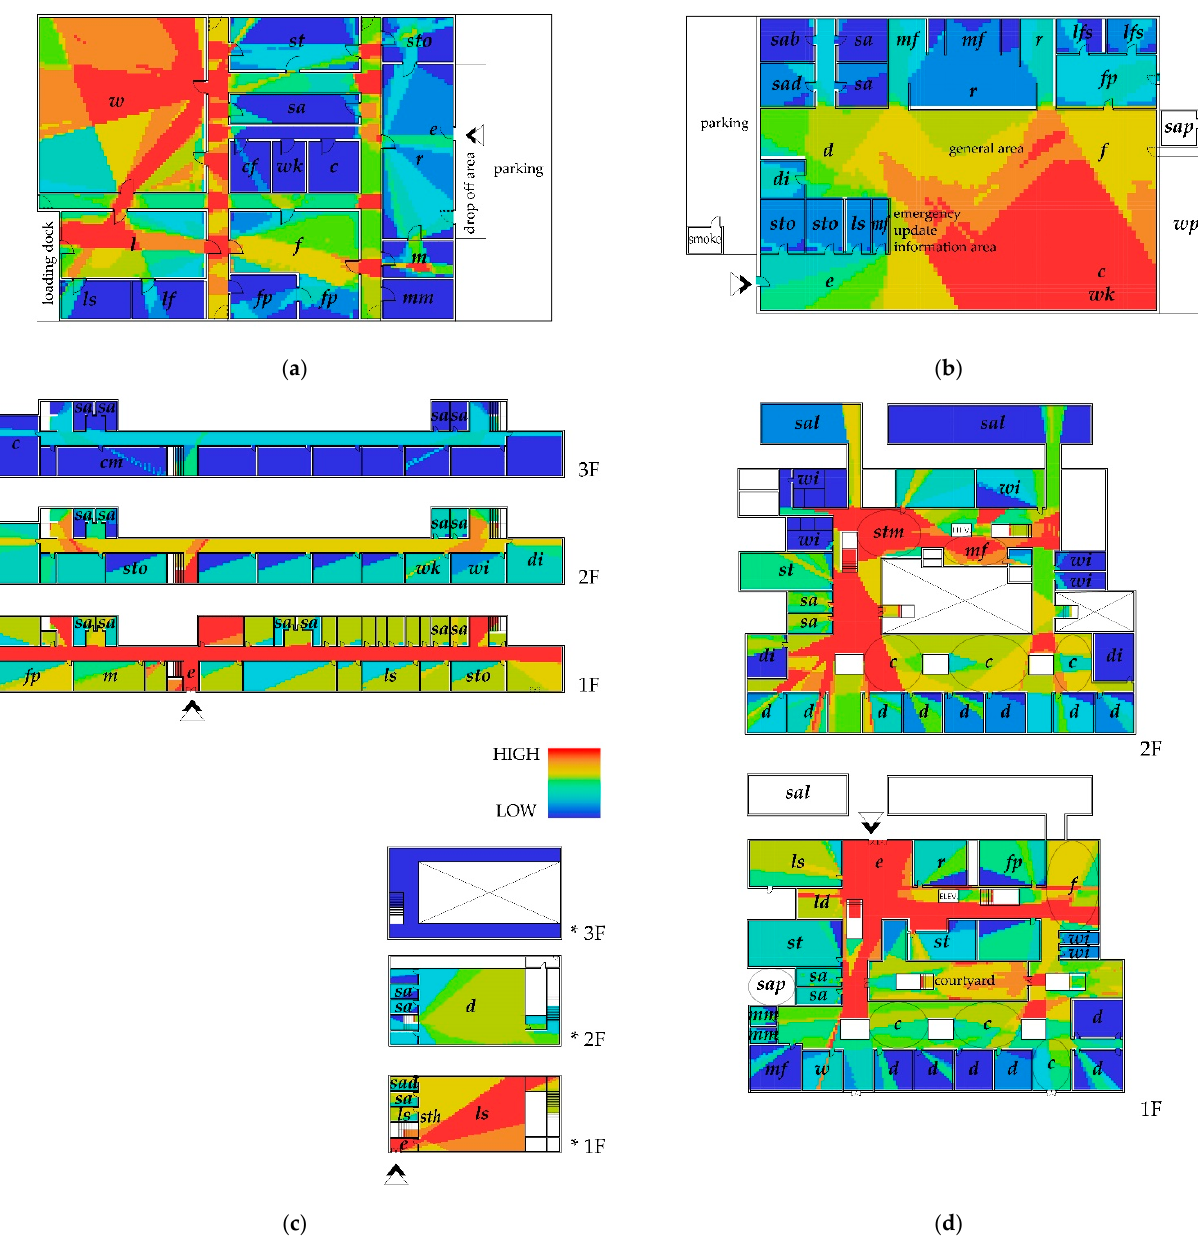
Figure 5. Visibility graph analysis of the cases (see Figure 2 for key to room functions; an asterisk in front the number indicates an annex building); ( a ) case 1 (U.S.); ( b ) case 2 (AU); ( c ) case 3 (JP1); ( d ) case 4 (JP2).